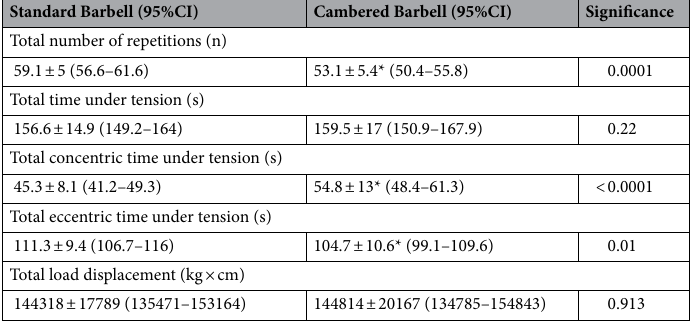
Table 2. Differences in whole training session volume variables measured during 3 sets of the cambered barbell and standard barbell bench press. CI confidence interval. *p < 0.05 significant different from standard barbell bench